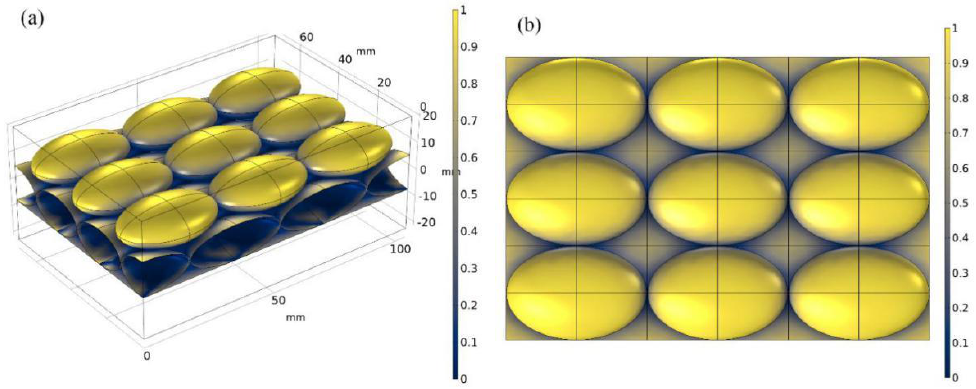
Figure 6. Distribution of calculated ambient view factor F amb . ( a ) Three-dimensional (3D) view. ( b ) Top view.